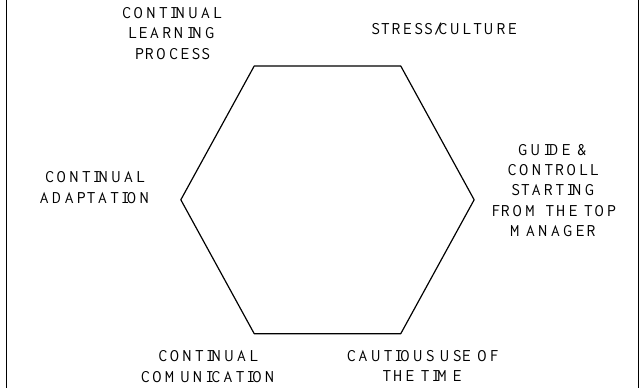
Figure 1: Conceptual And Operative Framework Of Organising-Cultural Integration In